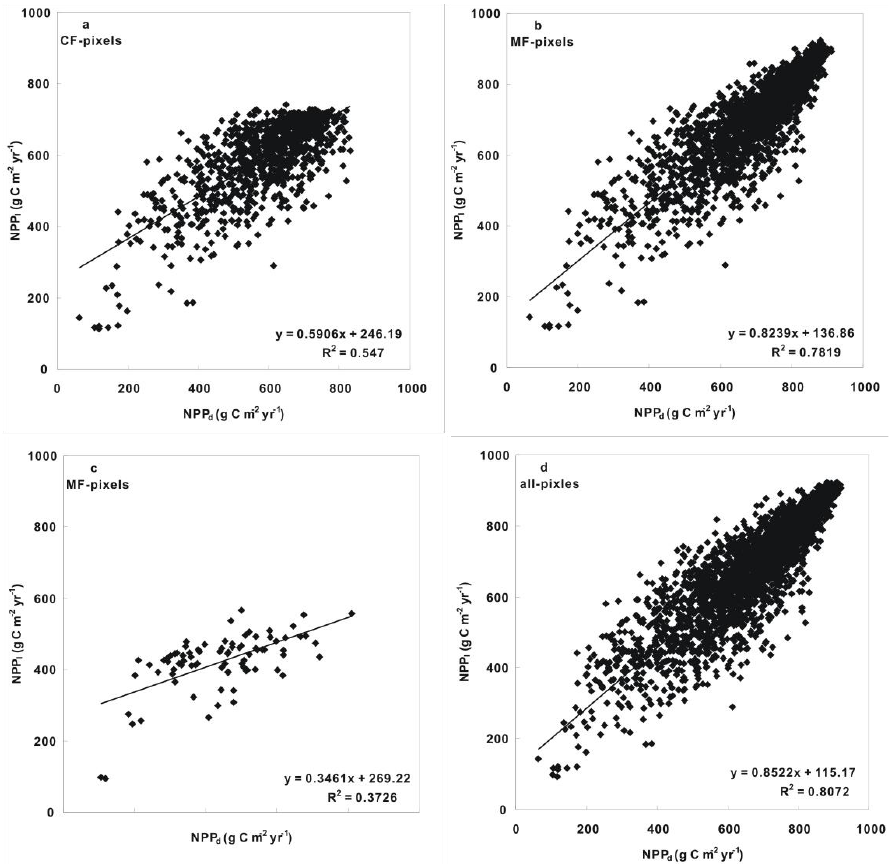
Fig. 11. Regression between distributed (NPP d ) and lumped (NPP l ) annual values after slope (SSI SL ) correction: (a) pixels dominated by Figure 11. Regression between distributed ( NPP d ) and lumped ( NPP l ) annual values 3 the coniferous forest (CF-pixels); (b) pixels dominated by the mixed forest (MF-pixels); (c) pixels dominated by open land (OL-pixels); and after slope ( SSI SL ) correction: (a) pixels dominated by the coniferous forest 4 (d) all pixels for all land cover types (CF-pixels); (b) pixels dominated by the mixed forest (MF-pixels); (c) pixels 5 dominated by open land (OL-pixels); and (d) all pixels for all land cover types 6 (all-pixels). 7